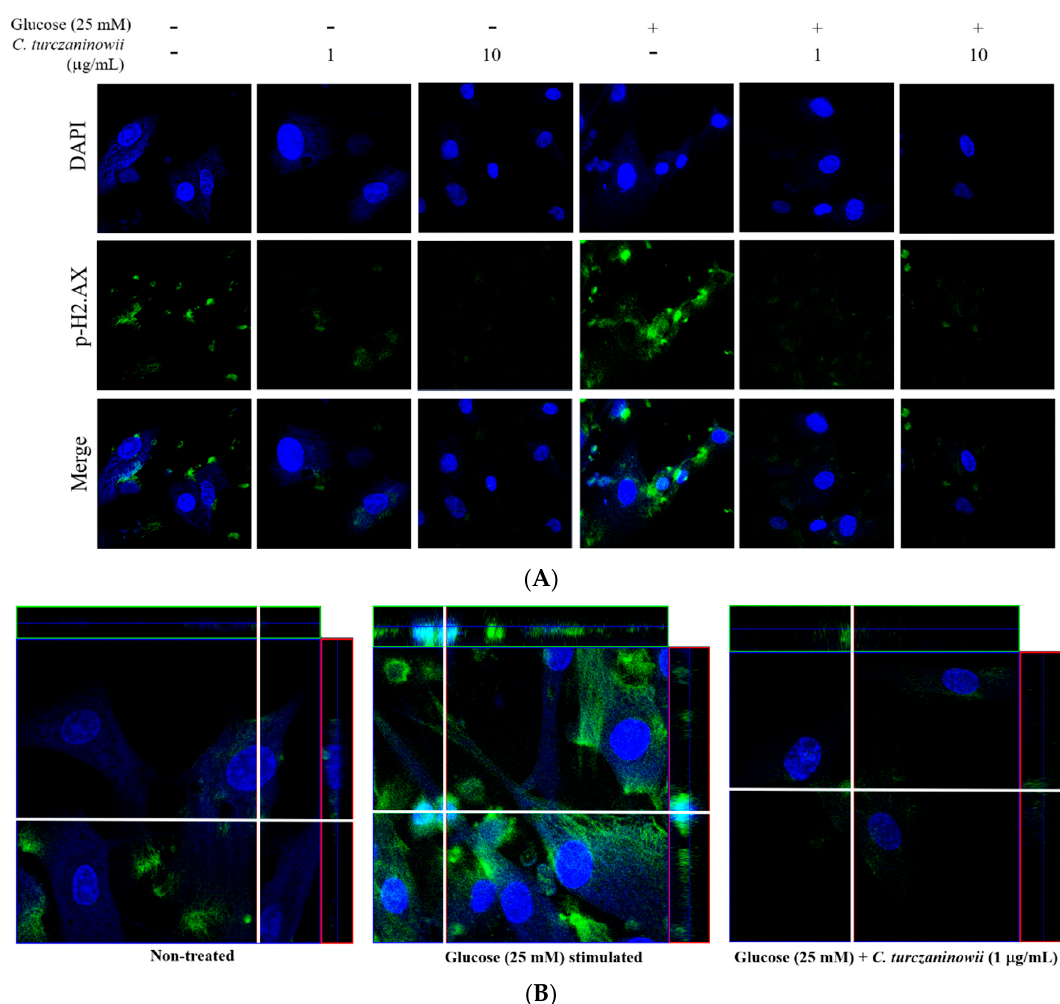
Figure 2. C. turczaninowii extract reduces the phosphorylation of H2.AX in hASMCs under high glucose conditions in vitro ( A ) with high magnification images ( B ). To confirm the effect of